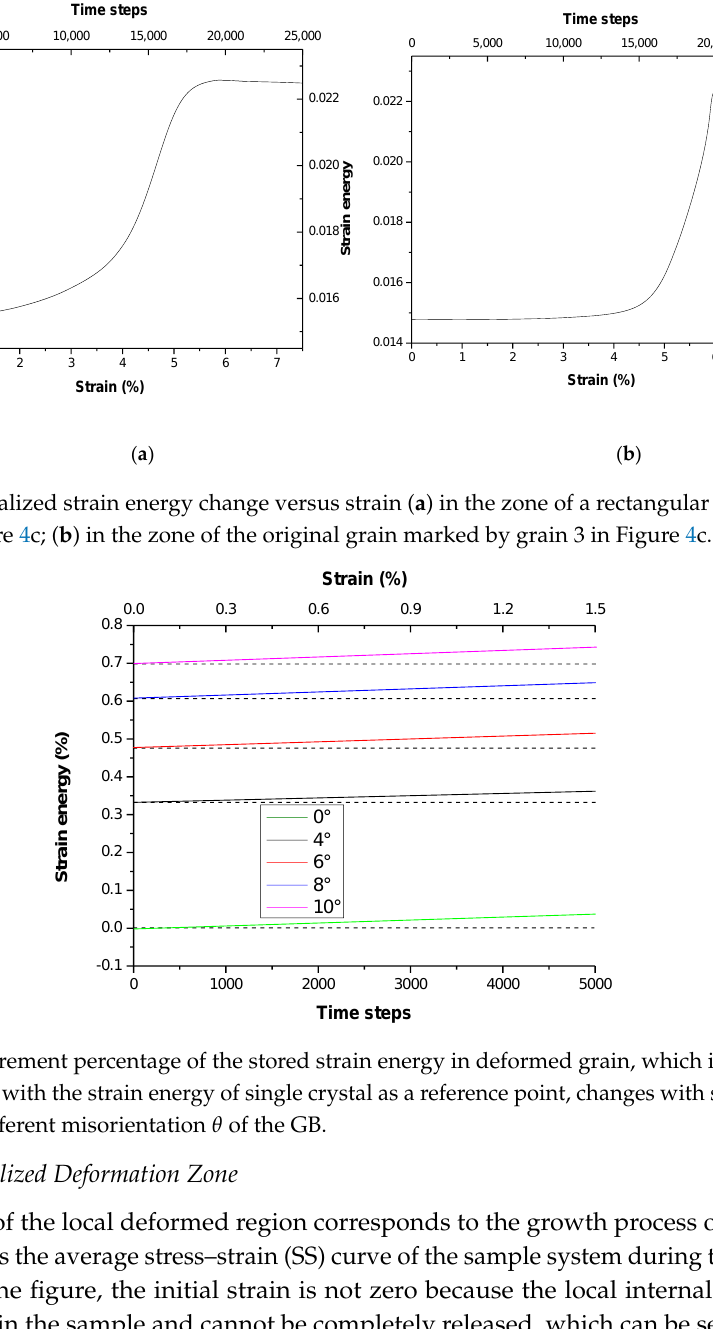
Figure 7. The larger the misorientation θ of the GB, the more the strain energy stored in the GB are, which is due to more dislocations in the GB with large θ . Under the condition of the small θ <10 ◦ of the GB, the strain energy stored in the GB is approximately linear with the angle θ of the GB.